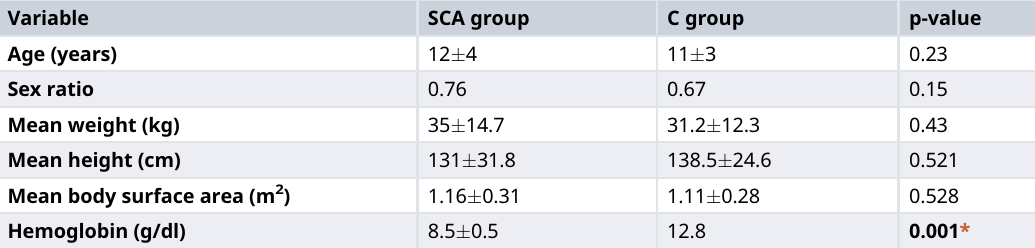
Table 1. Comparison of baseline characteristics of the two